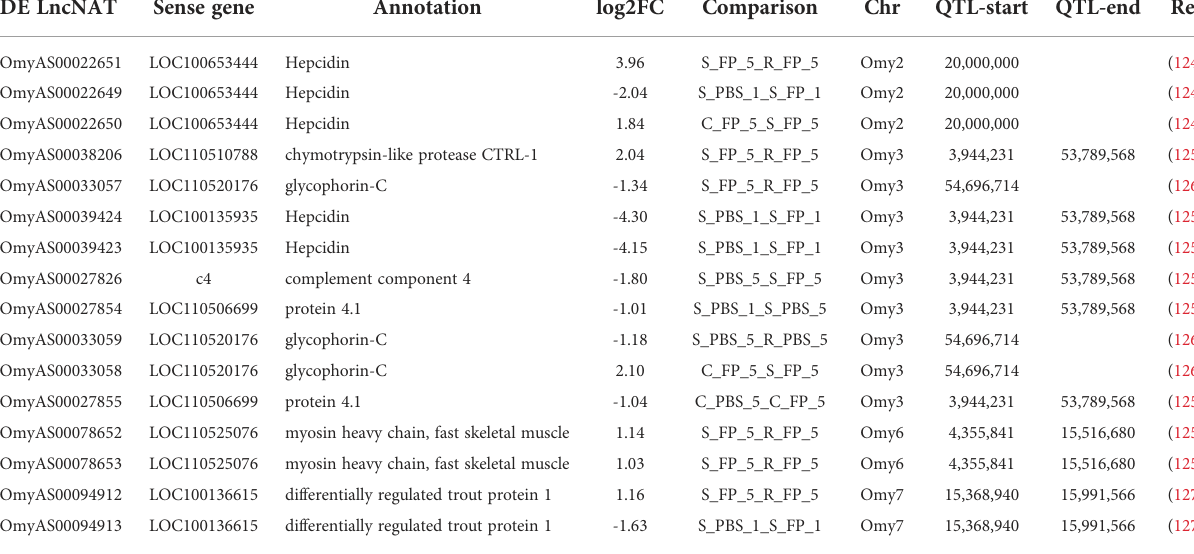
TABLE 3 DE lncNAT overlapping with previously published QTL for BCWD resistance in rainbow trout populations. DE LncNAT Sense gene Annotation